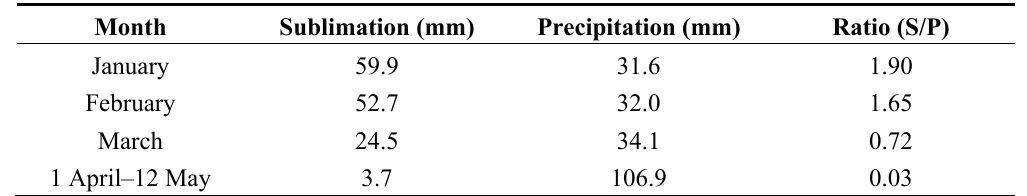
Table 3. The monthly precipitation and sublimation measured in Dadongshu Station in 2008 (modified from